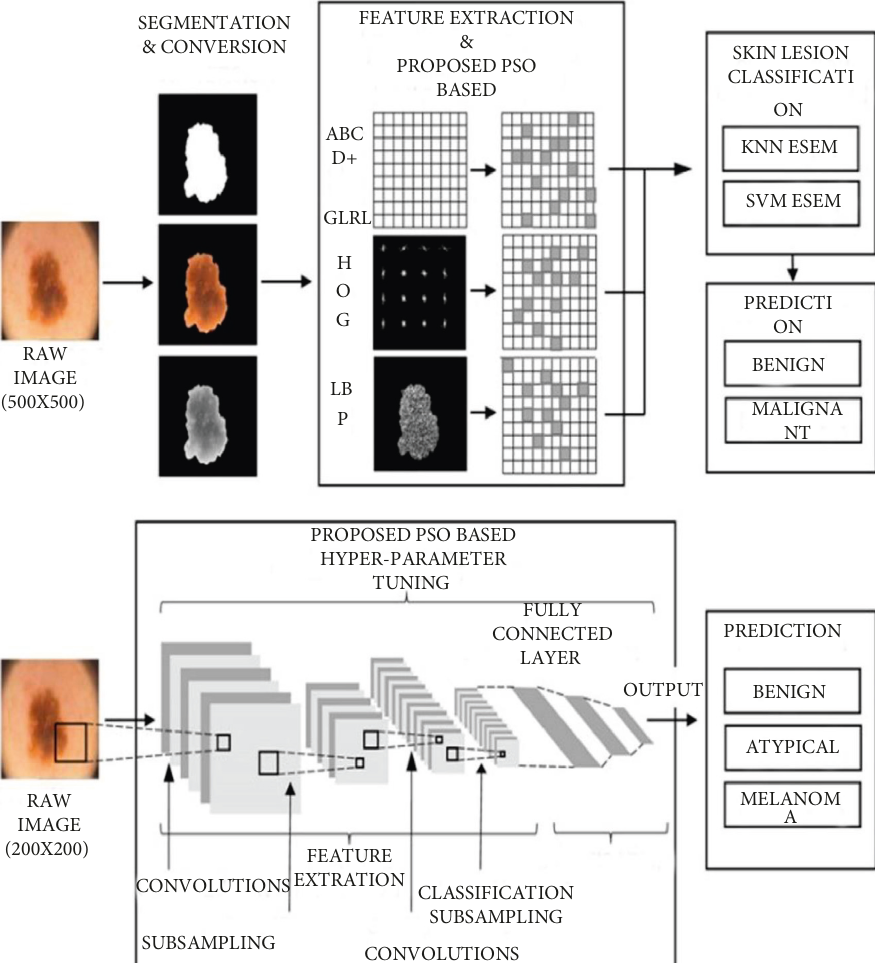
Figure 3: Proposed system architecture of Tan and